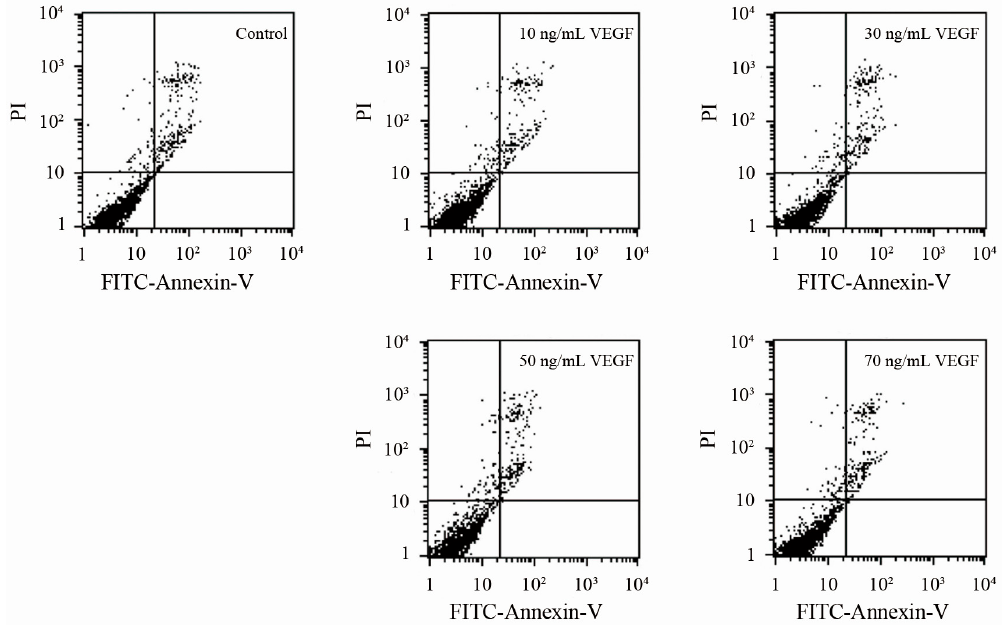
Figure 4. Apoptosis analysis of mDCs treated with different concentrations of VEGF.